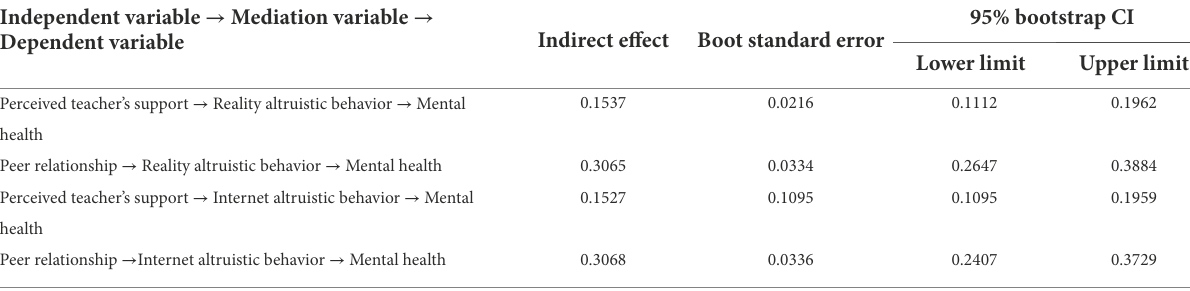
TABLE 2 Bootstrap analysis of the mediating